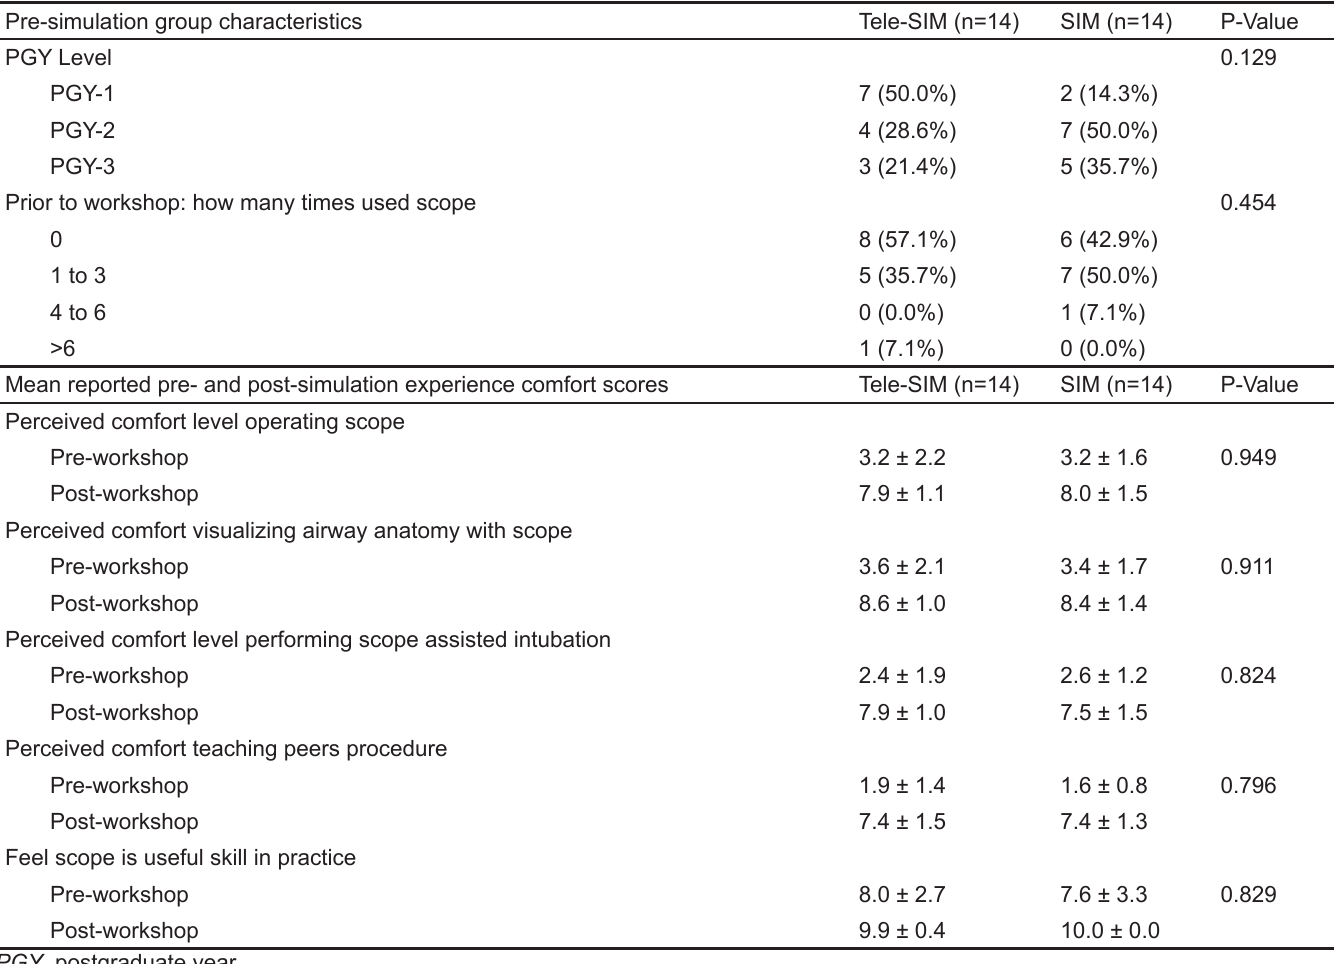
PGY , postgraduate